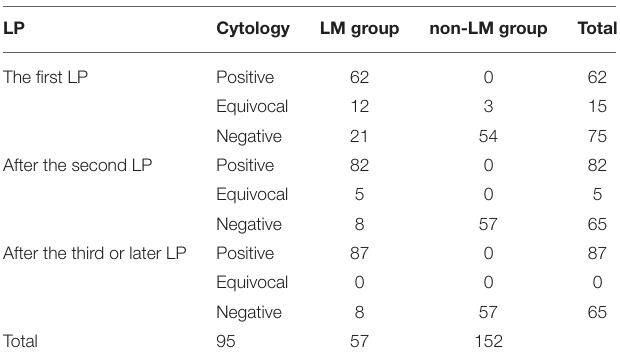
TABLE 5 | Diagnostic accuracy of LP.